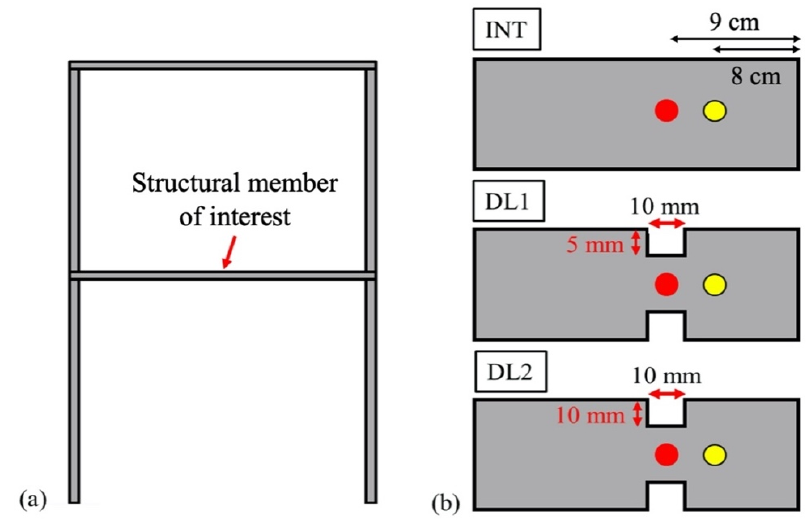
Figure 2. ( a ) Schematic of acrylic frame; ( b ) damage scenarios.